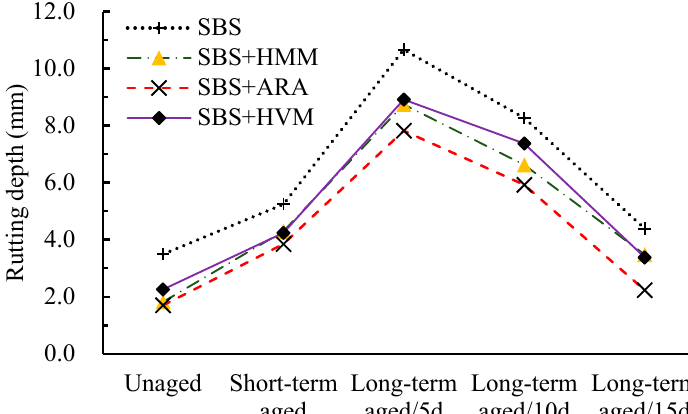
Figure 6. Rutting depth of different modified mixtures under different aging conditions.